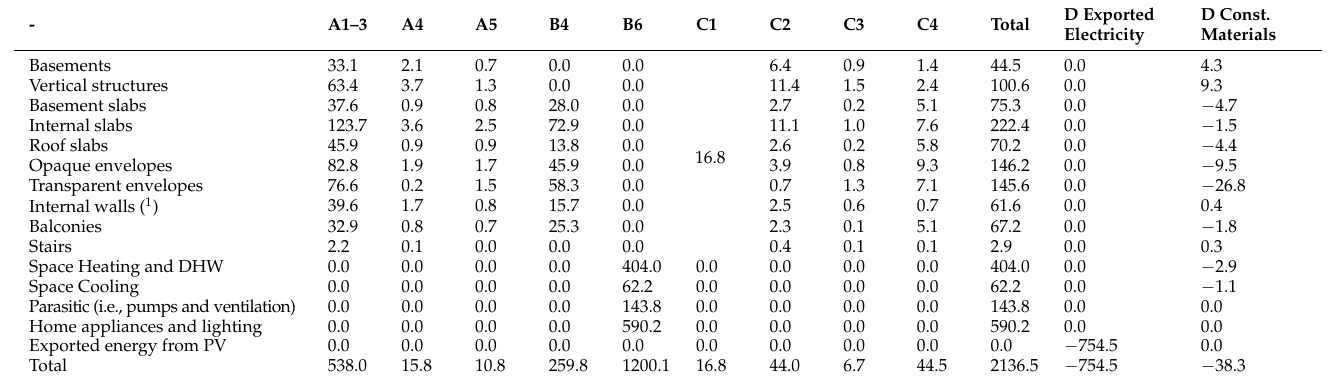
Table 7. Emissions of GWP total in kg CO 2 eq/m 2 of net area for an RSP equal to 50